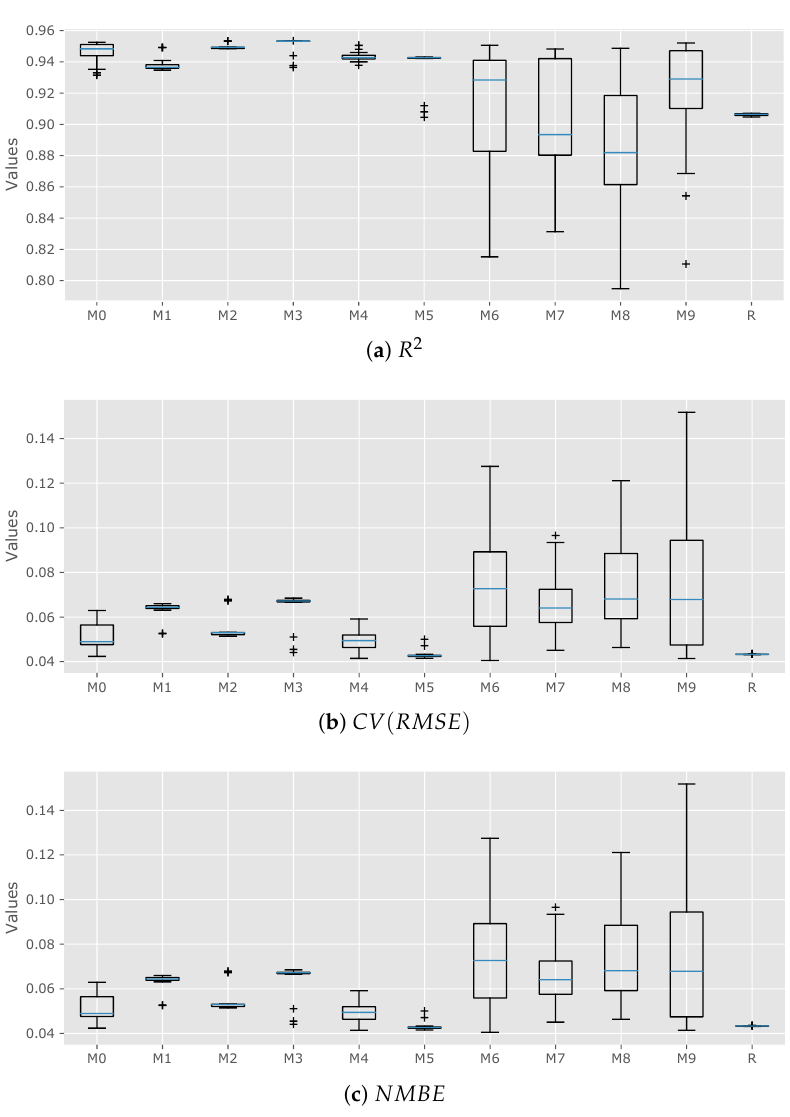
Figure 6. Uncertainty analysis (UA) of the 20 best models of each class ( M 0, M 1,..., M 9, R ). ( a ) R 2 , ( b ) CV ( RMSE ) and ( c ) NMBE